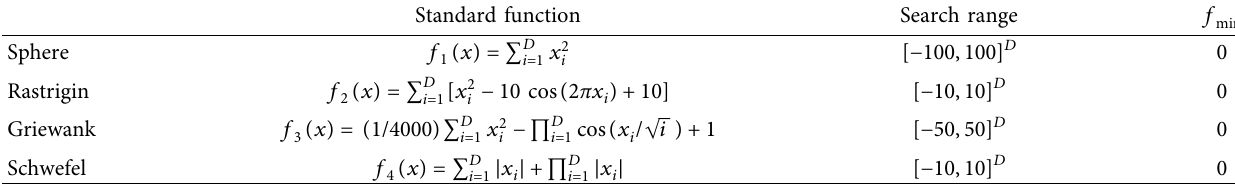
Table 2: The four standard test functions.